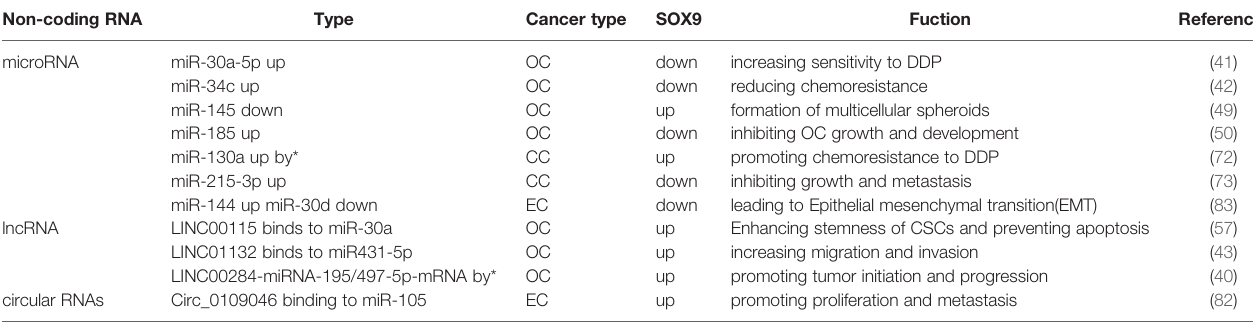
TABLE 3 | Studies on non-coding RNA in gynecological malignancy. Non-coding